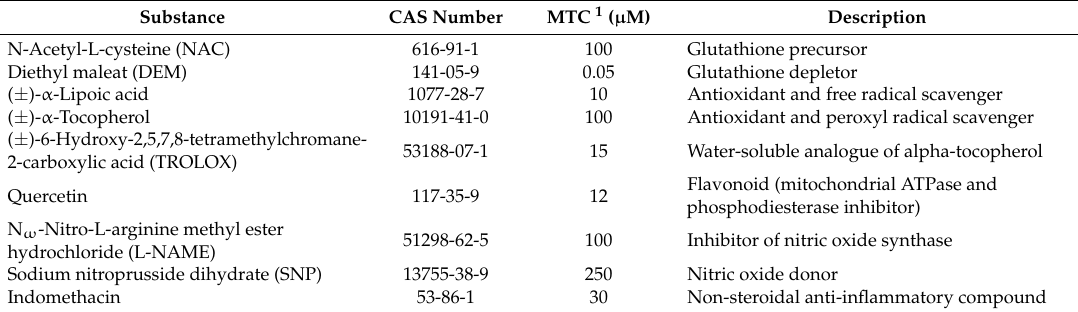
Table 2. Overview of the chemicals used as modulators in the cardiac toxicity produced by PCB126.